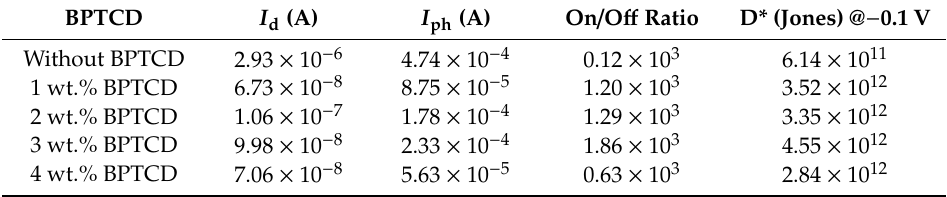
Table 1. Summarization of the I d , I ph and on / o ff ratio of the PePDs at − 0.5 V, and D* at 685